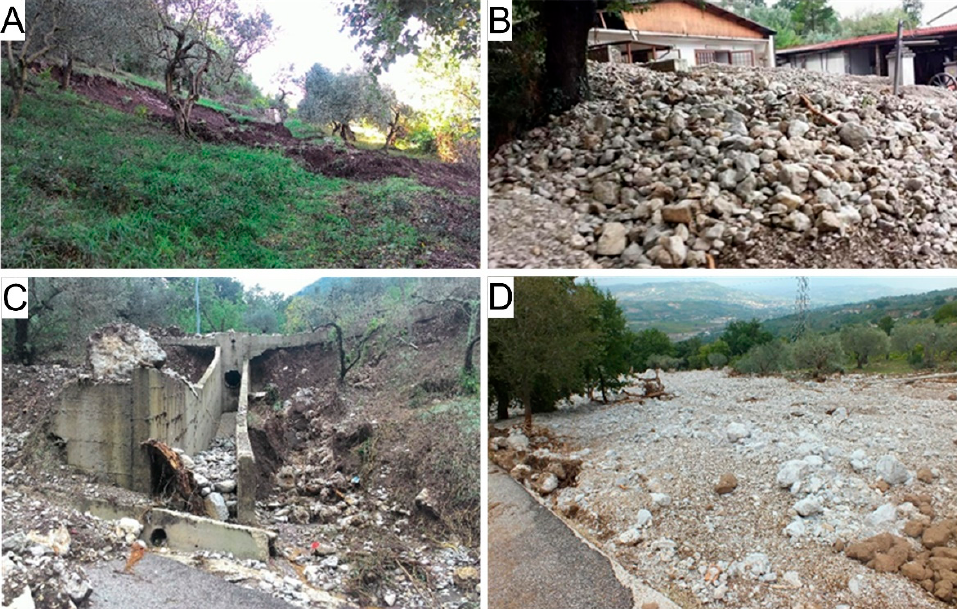
Figure 12. Slope instabilities triggered on slopes: ( A ) Earth flow; ( B ) runoff-generated debris flow in the town of Paupisi; ( C ) poorly sized work in a channel; ( D ) runoff-generated debris flow deposit.